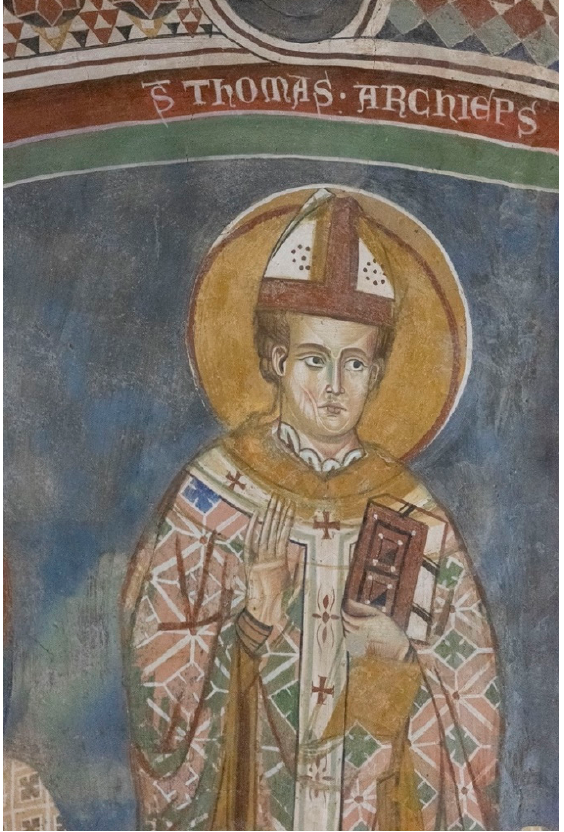
Figure 14. Sacro Speco, Subiaco (Italy), Lower Church. Fresco. Lunette, particular of St. Thomas Becket. Photo: Davide Giannetti.